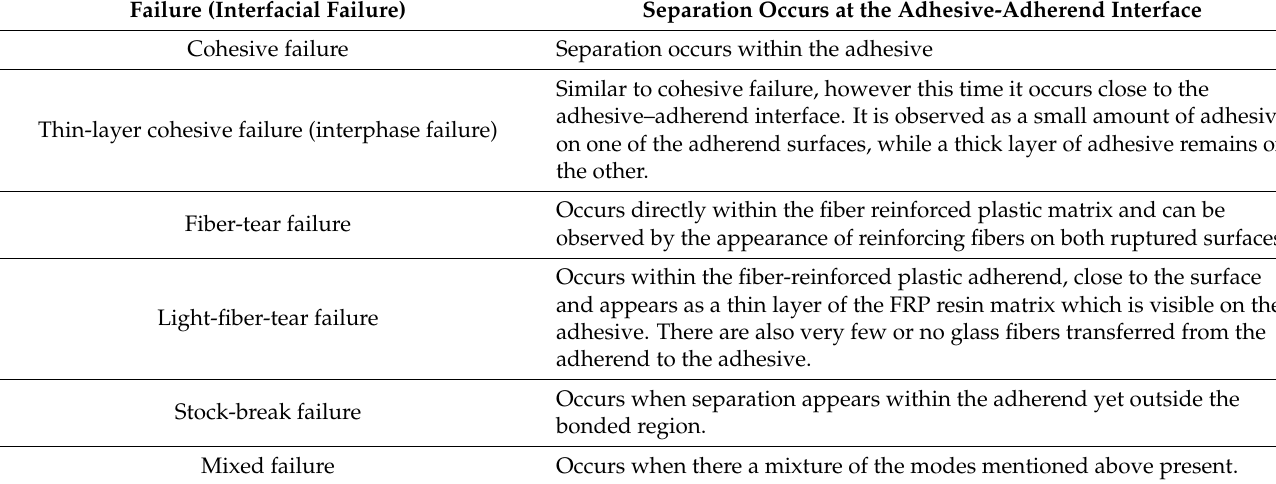
Table 2. Summary of the failure modes that occur within adhesively bonded joints